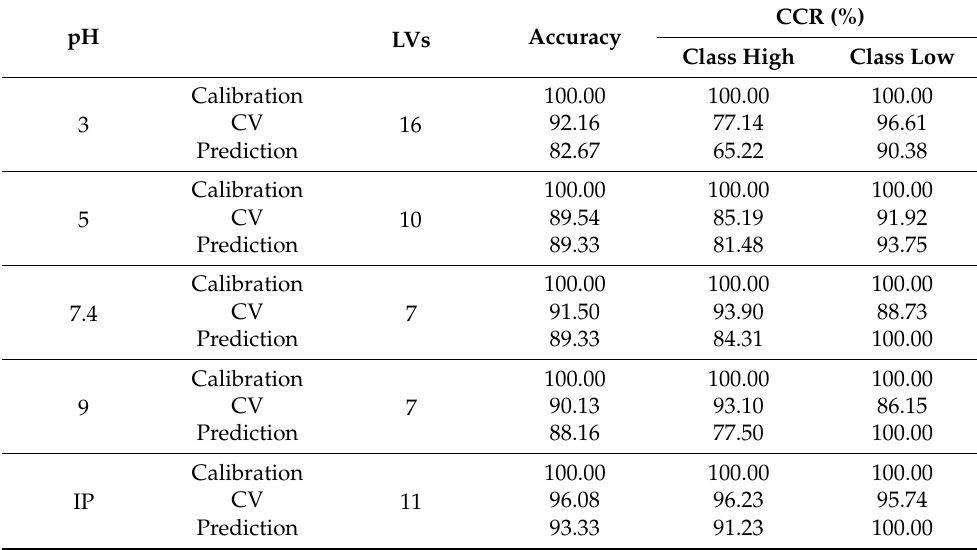
Table 3. PLS-DA: number of latent variables (LVs), overall accuracy and correct classification rate (CCR%) for the individual categories on the training set (in calibration, and cross-validation (CV)) and the test set